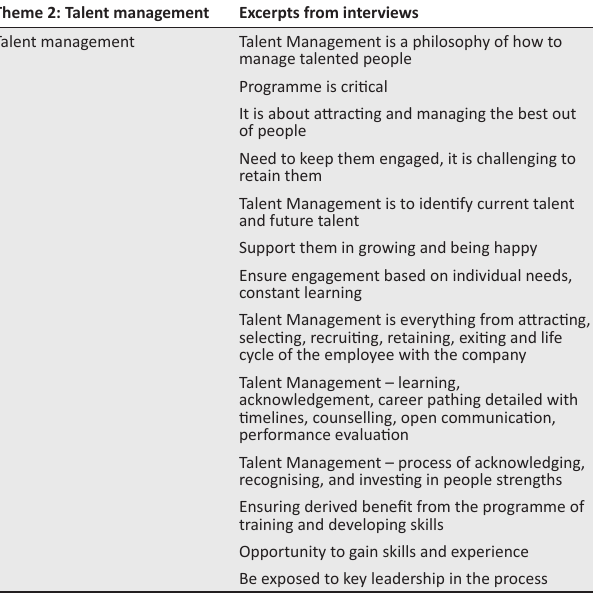
TABLE 2: Defining talent